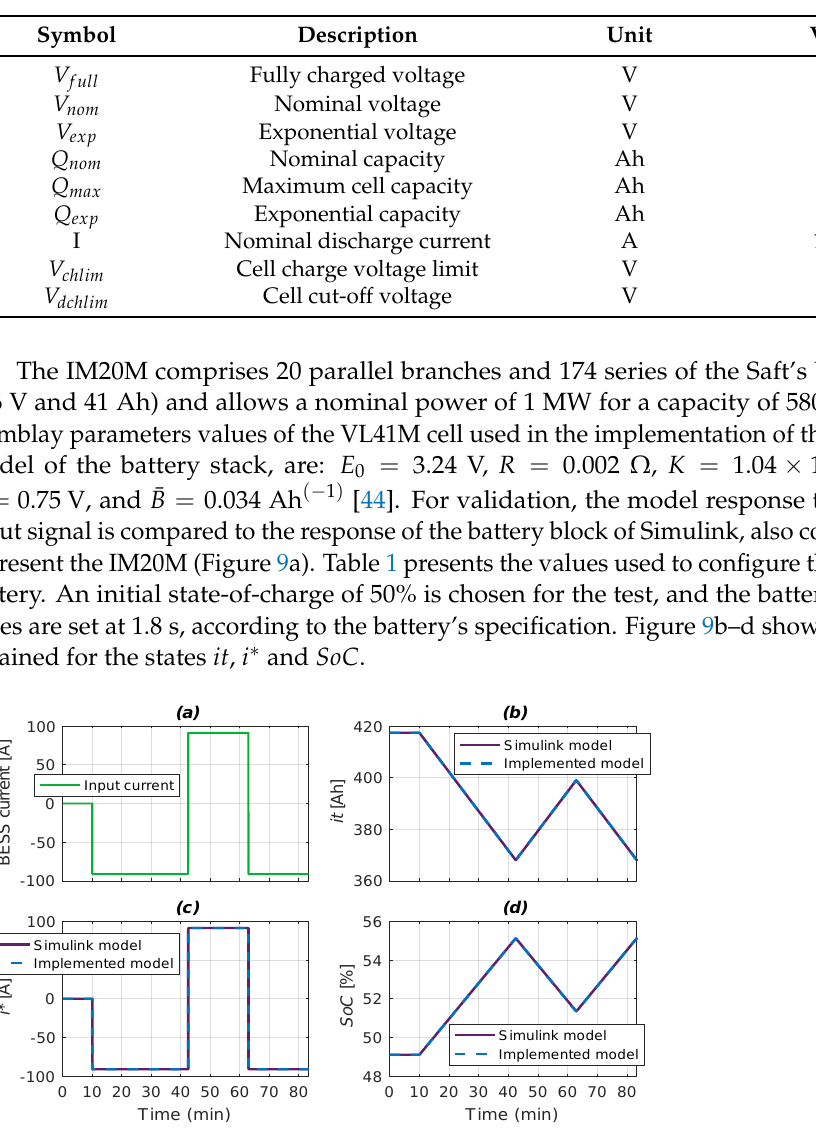
Figure 9. Validation of MATLAB implementation: ( a ) input current. In ( b – d ) the signals obtained for it , i ∗ and SoC are